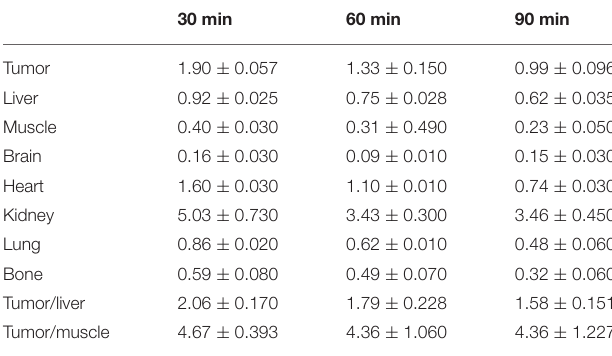
TABLE 1 | The data of uptake in interest organs in small animal PET imaging